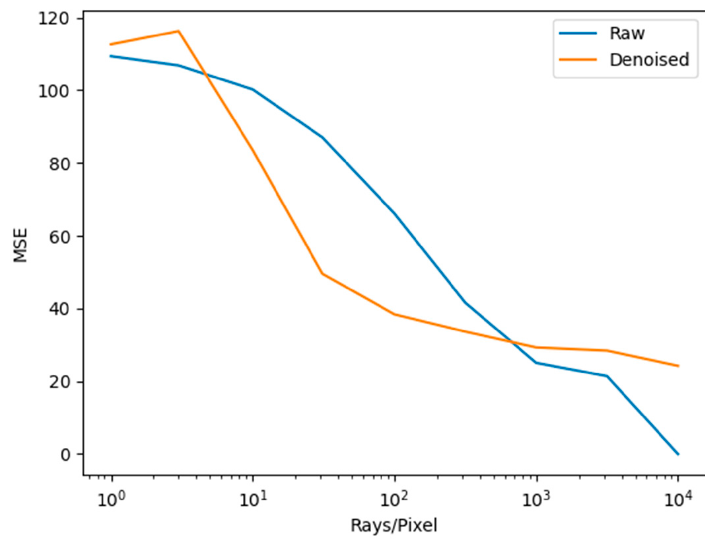
Figure 6. Mean squared error (MSE) of images, raw and Figure 6 . Mean squared error (MSE) of images, raw and denoised.